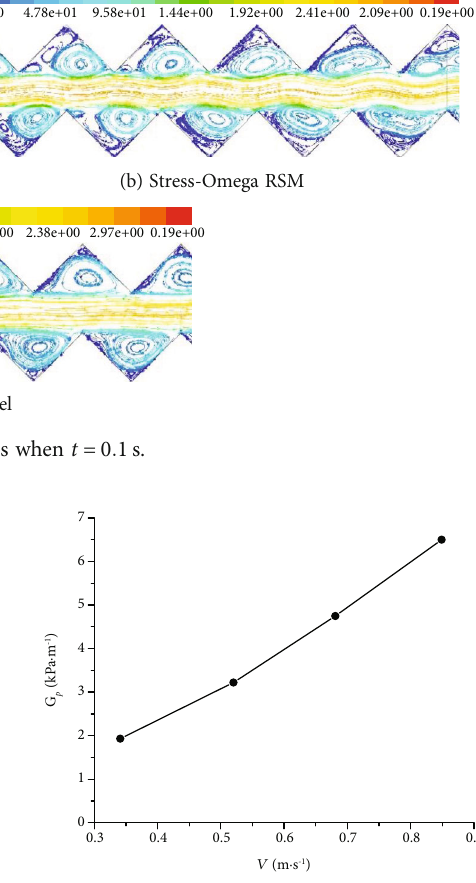
Figure 10: The pressure gradient absolute value-velocity